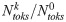
Results of MEX embedding.The bar graphs in the sub-plots show the motif densities (number of motifs divided by the number of original terminal words) and the line plots chart decrease in the number of tokens Ntoksk/Ntoks0 as more motifs are embedded in the network. (A) gives the results for the real corpora (USEC, SAC, and BC) while (B), (C), and (D) show the difference between each real corpus, its shuffled equivalent and its POS-shuffled equivalent.